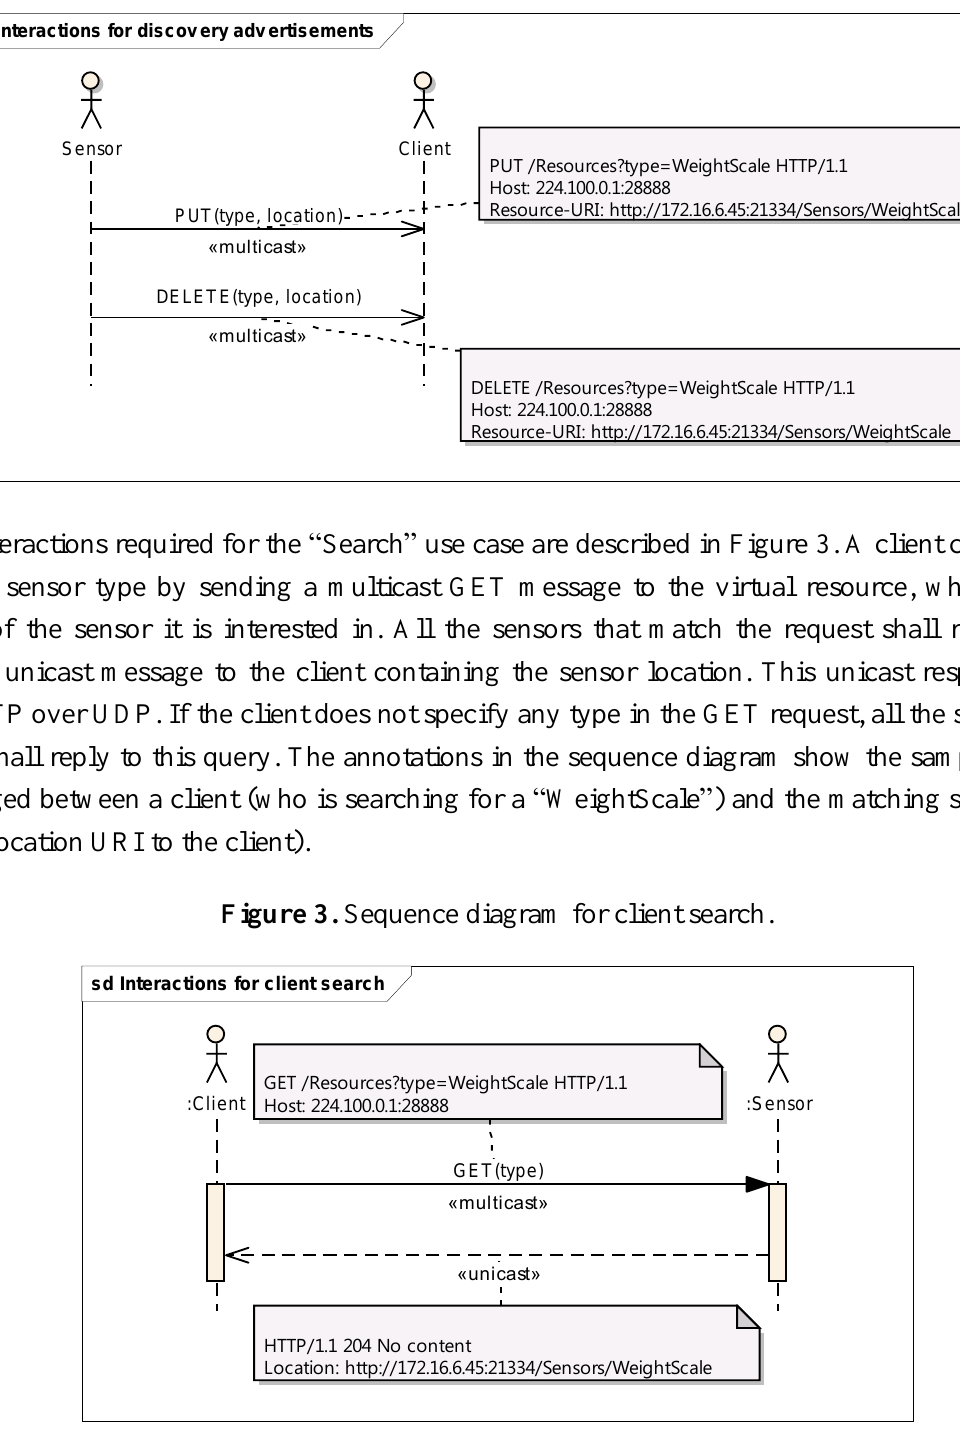
Figure 2. Sequence diagram for sensor advertisement.